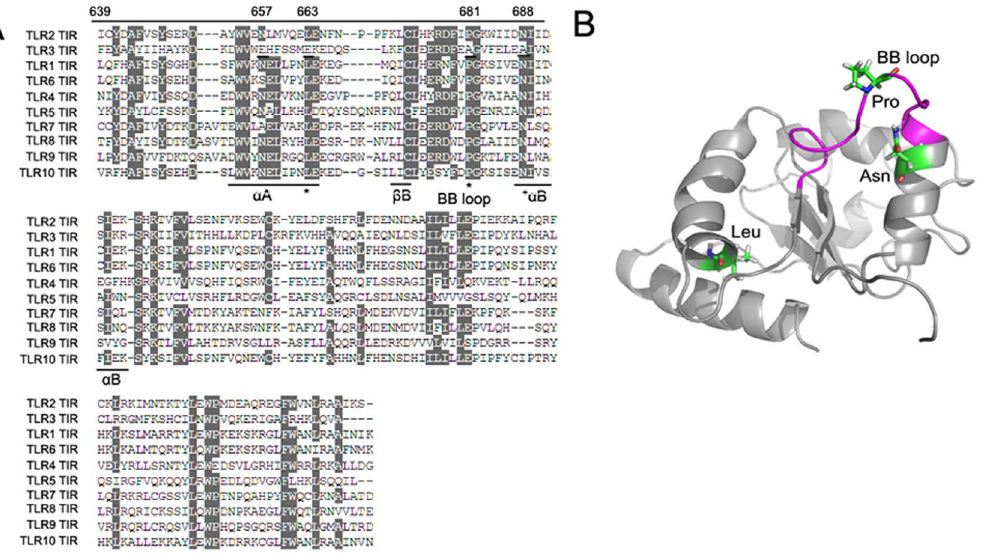
Figure 1. Conserved amino acid residues in all but not human TLR3 TIR domain and their location in the crystal structure of human TLR2 TIR. A, All of the TIR domains, including human TLR2, TLR3, TLR1, TLR6, TLR4, TLR5, TLR7, TLR8,TLR9 and TLR10, were aligned. The sequences responsible for the structure of a A, b A, a B, and the amino acid residues specific for human TLR3 TIR and one (657 E) specific for TLR3, but semi- conserved in all other human TLRs TIRs were underlined. The BB loop was indicated as the sequence between b A and a B, and three conserved amino acid residues in all of the TLRs, except for the TLR3 TIR domain, such as L, P and N, were indicated as‘‘*’’. The numbers indicate the positions of the amino acid residues in human TLR2. B, Stick representation of all three conserved amino acid Leu (663), Pro (681) and Asn (688), and highlighting BB loop ( pink ) in the cystal structure of human TLR2 TIR domain.